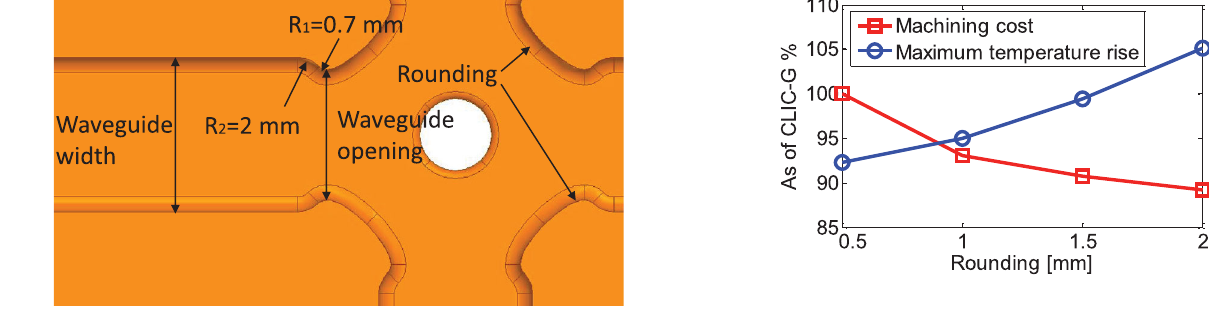
FIG. 8. Geometrical parameters in one structure cell related to the rounding study.